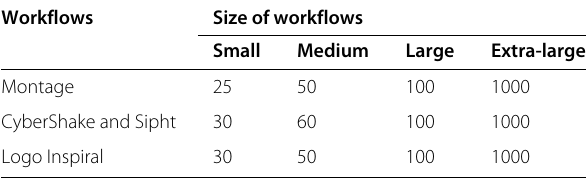
Table 2 Types of workflows and their sizes